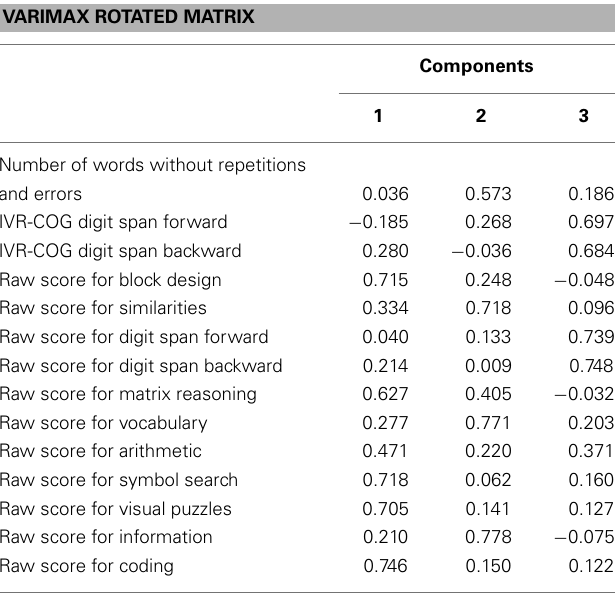
Table 9 | Principal component analyses with a varimax rotation for IVR tasks and the raw scores of the 10 core subtests of